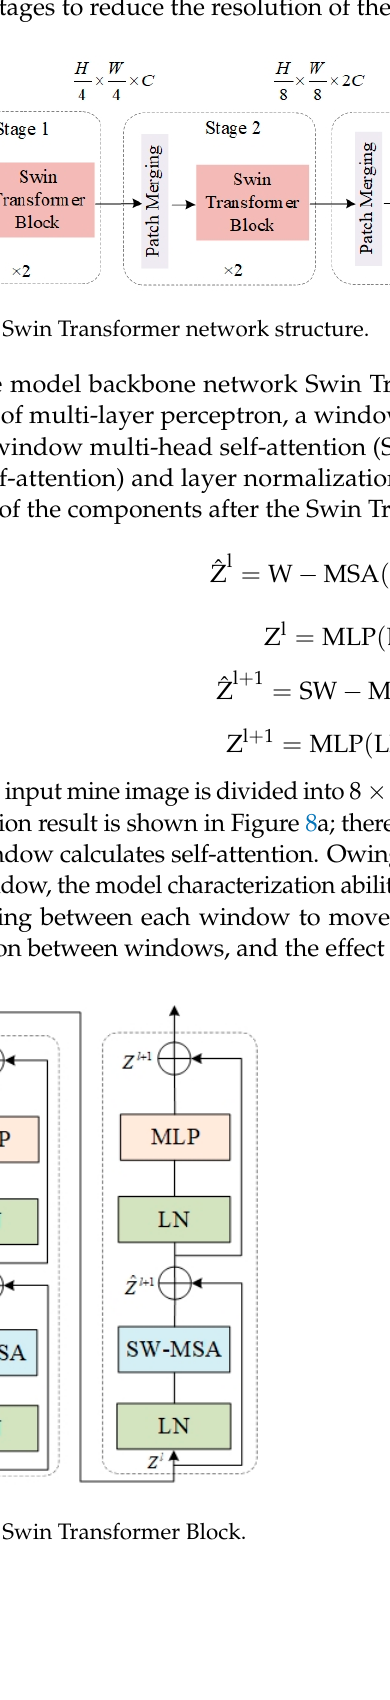
( b ) Figure 8. The division window effect. ( a ) W-MSA division window. ( b ) SW-MSA dividing win- dow. The Swin Transformer network structure is added to the YOLOv5 enhanced feature extraction network to form the enhanced feature extraction network of the ST-YOLOv5 detection model. The backbone feature extraction network outputs three effective feature layers, which are predicted by the output of the enhanced feature extraction network, and the structure is illustrated in Figure 9.